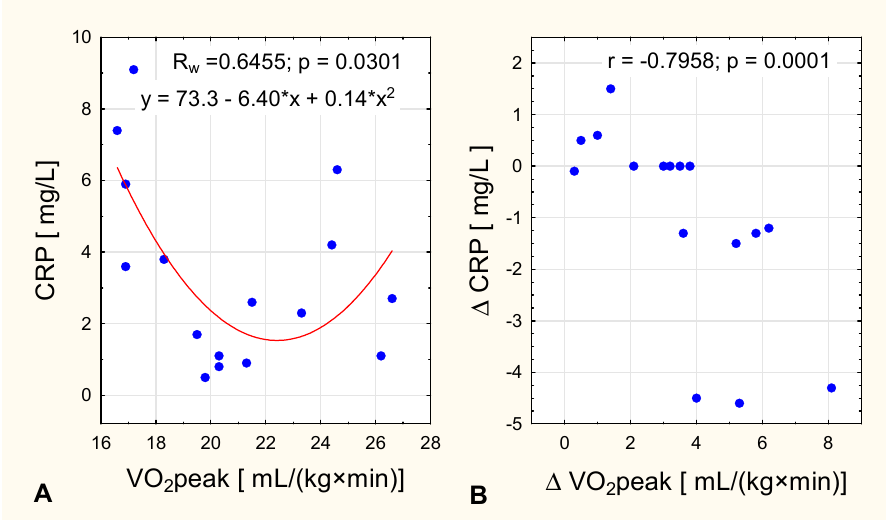
Figure 3. In women with obesity, the relationship between VO 2 peak and ( A ) post-intervention CRP concentration (nonlinear squared correlation) and ( B ) and change in CRP concentration across the intervention.